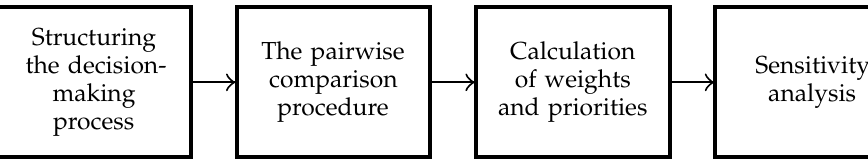
Figure 2. The analytic hierarchy process